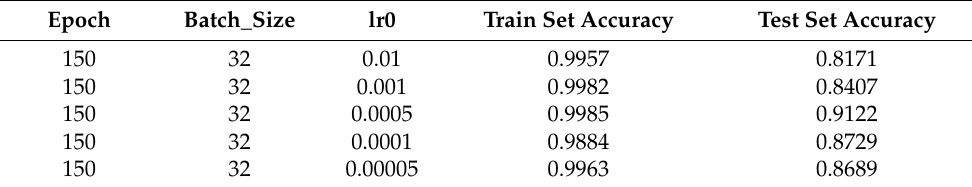
Table 2. Model accuracies corresponding to different initial learning rates.